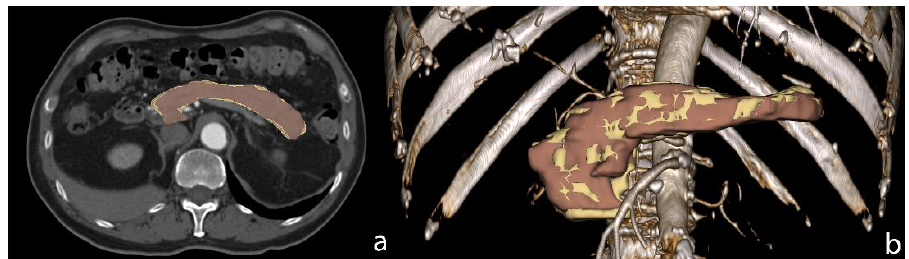
Figure 1. Pancreas AI segmentation (yellow) versus manual segmentation (brown) on axial CT image ( a ) and Volume Rendering image ( b ). The DSC of this case was 0.86.